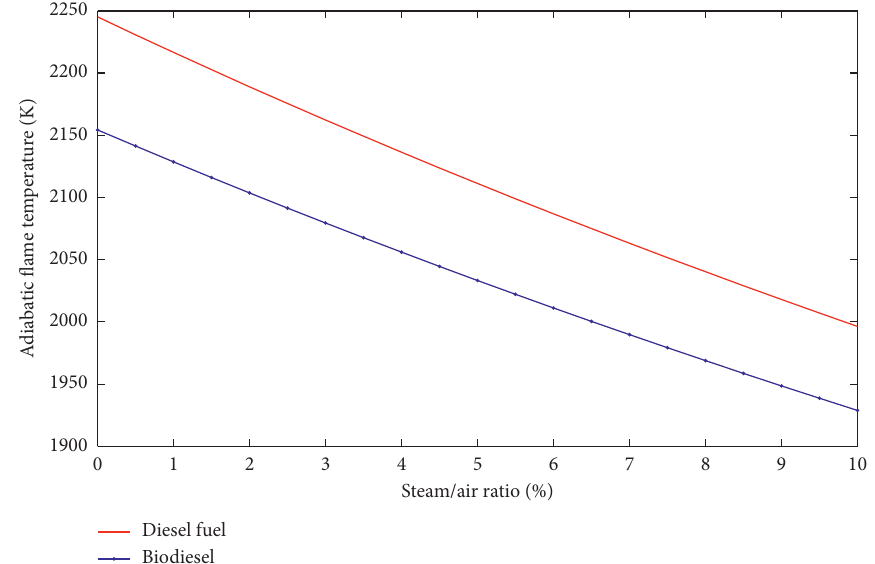
Figure 11: Adiabatic flame temperature comparison of biodiesel and diesel fuels at ϕ � 1.2.